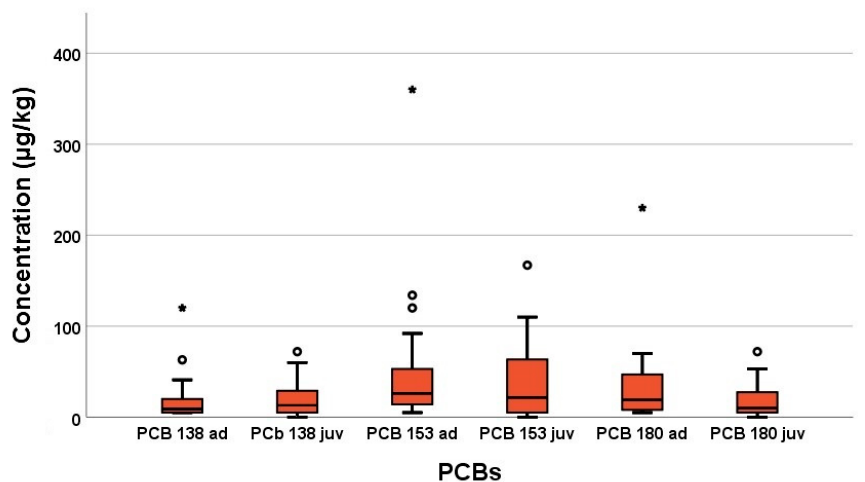
Figure 2. Concentrations of polychlorinated biphenyls in organs of common swifts detected in 2016–2018 in µ g/kg wet weight. The box plot shows median (horizontal line in centre), the 25th percentile (box border at bottom) and the 75th percentile (box border at top). The upper and lower ends of the whisker show the maximum and minimum values. The single data points are outliers. The asterisks are extreme outliers. Table 2. Concentrations of organochlorine pesticides and polychlorinated biphenyls in pooled organ samples of adult and juvenile common swifts detected in each year from 2016 to 2018 in μ g/kg wet weight (ww): Mean ± SD a (Median; Xmin b – Xmax c ). Compounds